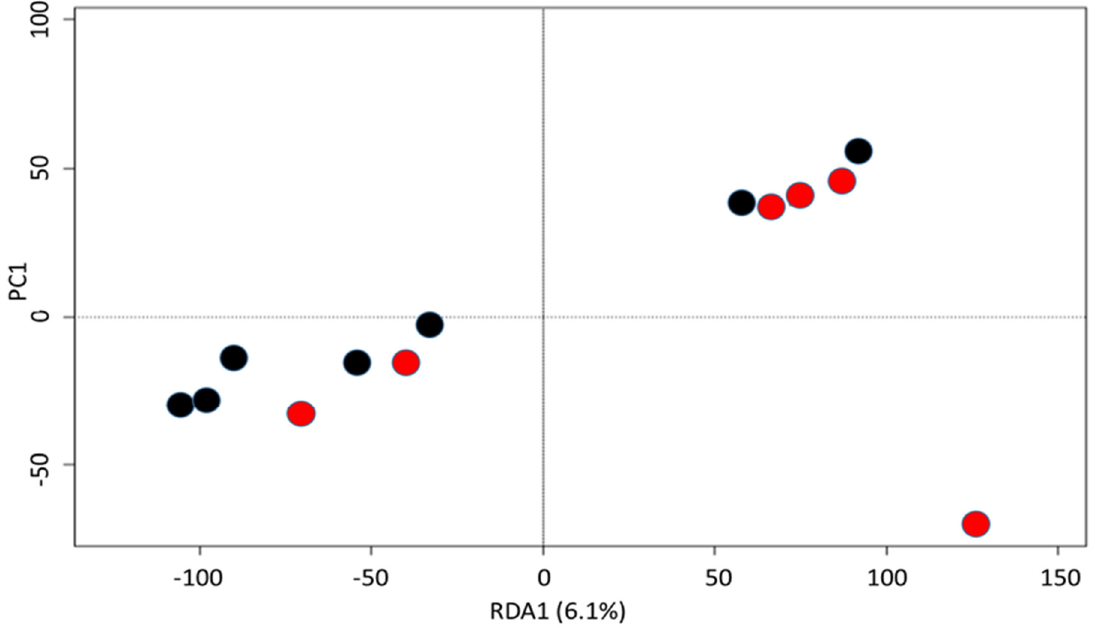
Figure 4. Beta diversity of the bacterial community microbiota identified in the surgical site during elective caesarean section in positive (red) and negative (black) culture samples. Multidimensional non- metric scaling (NMDS) plots generated by Bray–Curtis dissimilarity distances (model stress = 0.2122) and JACCARD matrix (model stress = 0.2774) were